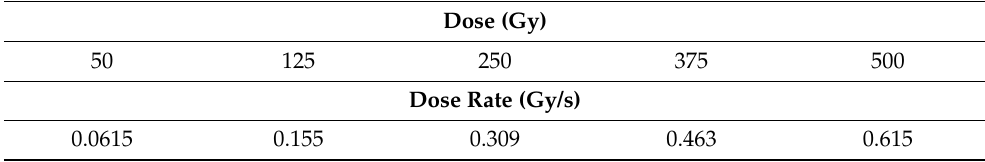
Table 1. Used dose and dose rates for phage solution proton irradiation.